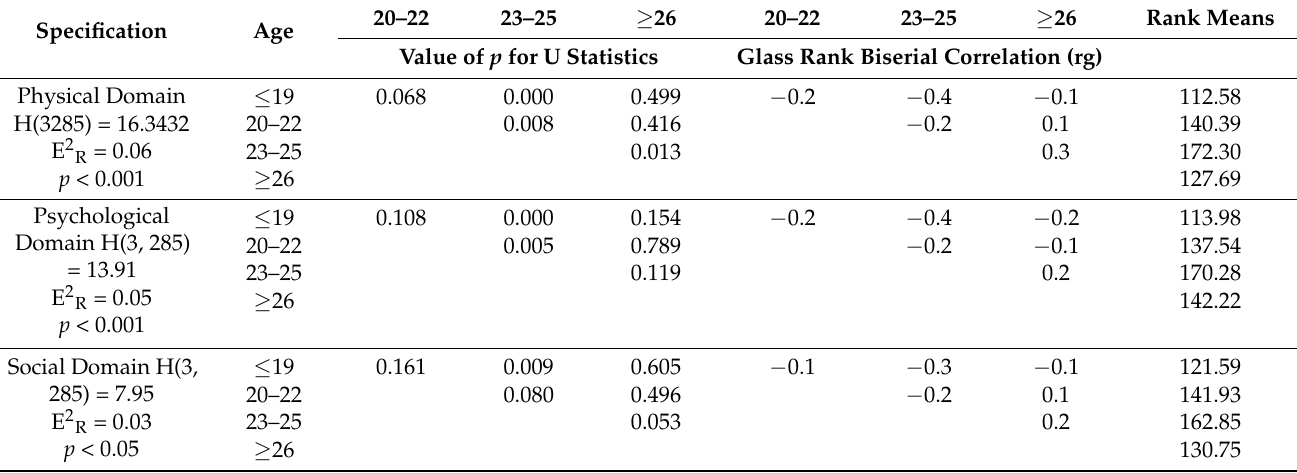
Table 6. Satisfaction with life, health, and particular domains of quality of life (WHOQOL-BREF) of female students by age (H test, E 2 R , U test,